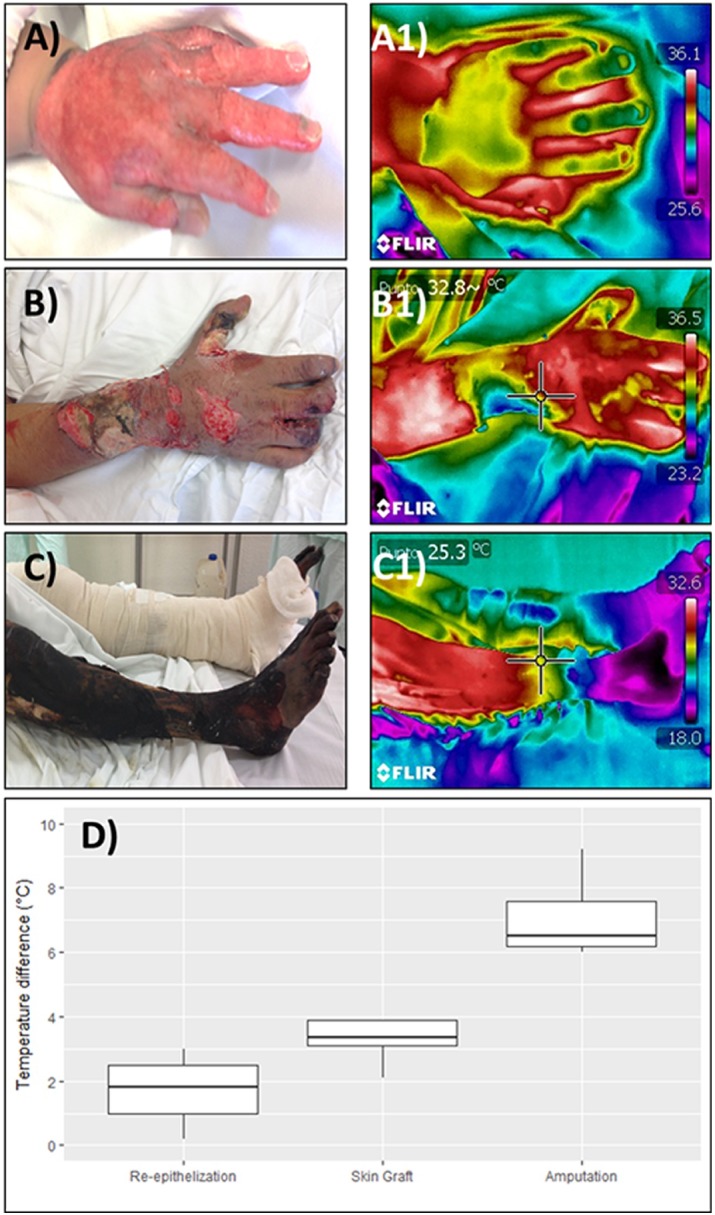
Thermograms and treatment groups.Clinical images (A to C) and thermograms (A1 to C1) were obtained during the first three days after the injury, the patients were followed up until discharged, and their outcome classified as healed by conservative treatment, skin graft or amputation. Significant differences in the temperature difference (TD) between injured and healthy tissue across all groups were found (D). Panels A and A1 represent an injury that healed by epithelization, B and B1 one that required a skin graft (note the colder region on the ulnar surface of the forearm), and C and C1 an injury that required amputation. Noteworthy in this last image, even though all the leg skin looks charred in the clinical image, the thermogram suggested that only the feet were non-viable.